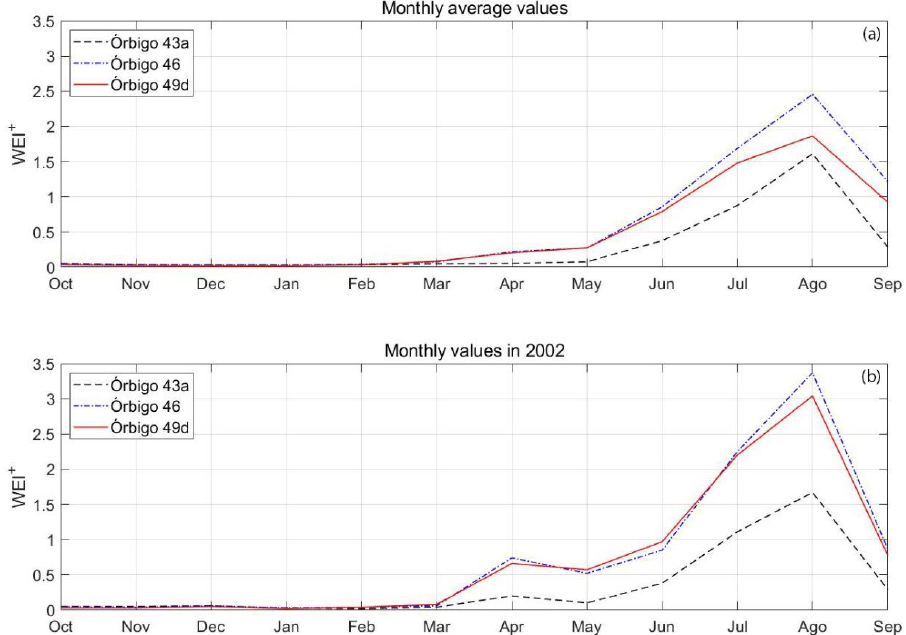
Figure 7. Monthly average values of the WEI + ( a ) and monthly values of the WEI + in 2001 ( b ) in three river stretches in the upper (Ó rbigo 43a), middle (Ó rbigo 46) and lower (Ó rbigo 49d) parts of the basin (Figure 3).